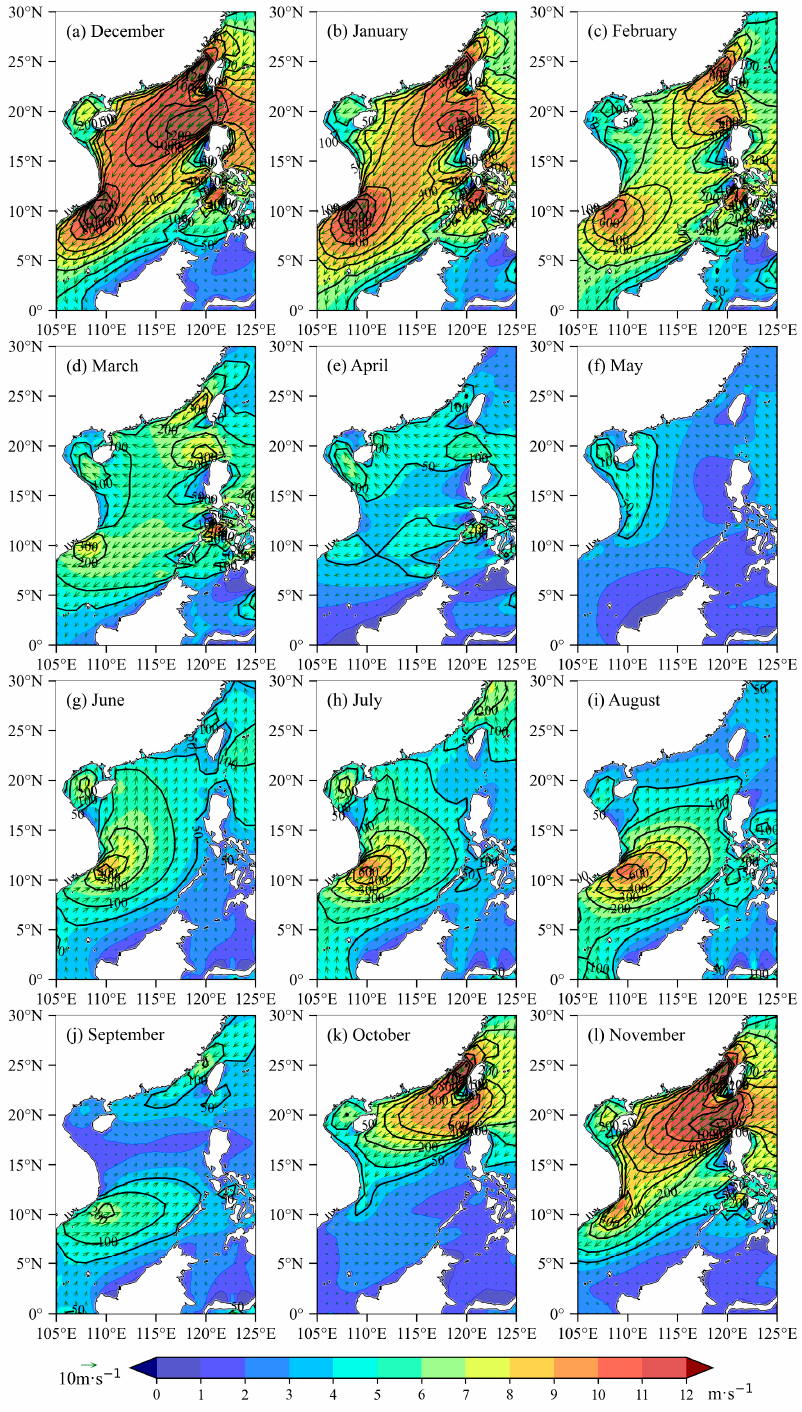
Figure 4. The monthly mean distribution of wind (shaded, vector, and unit: m ‧ s − 1 ) and wind power density (contour, unit: W ‧ m − 2 ) over the SCS from 1979 to 2021.